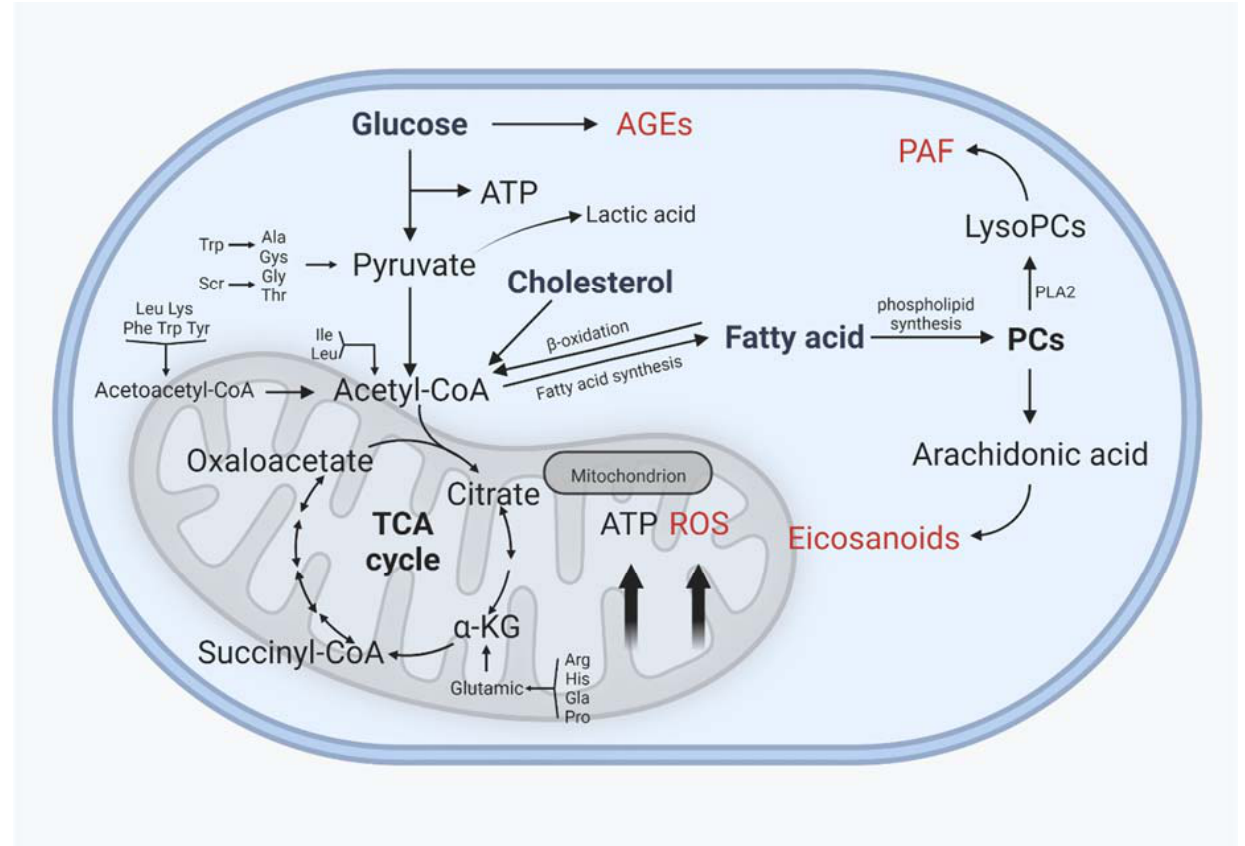
Figure 4. Interactions between glucose and protein metabolism and lipid metabolism in chondrocytes. AGEs: advanced glycation end products, ROS: reactive oxygen species, PAF: platelet-activating factor. AGEs, ROS, PAF, and eicosanoids are implicated in the inflammatory process of osteoarthritis, and their levels rise as OA progresses. (Figure was created with Biorender.com and accessed 20 September 2022.)